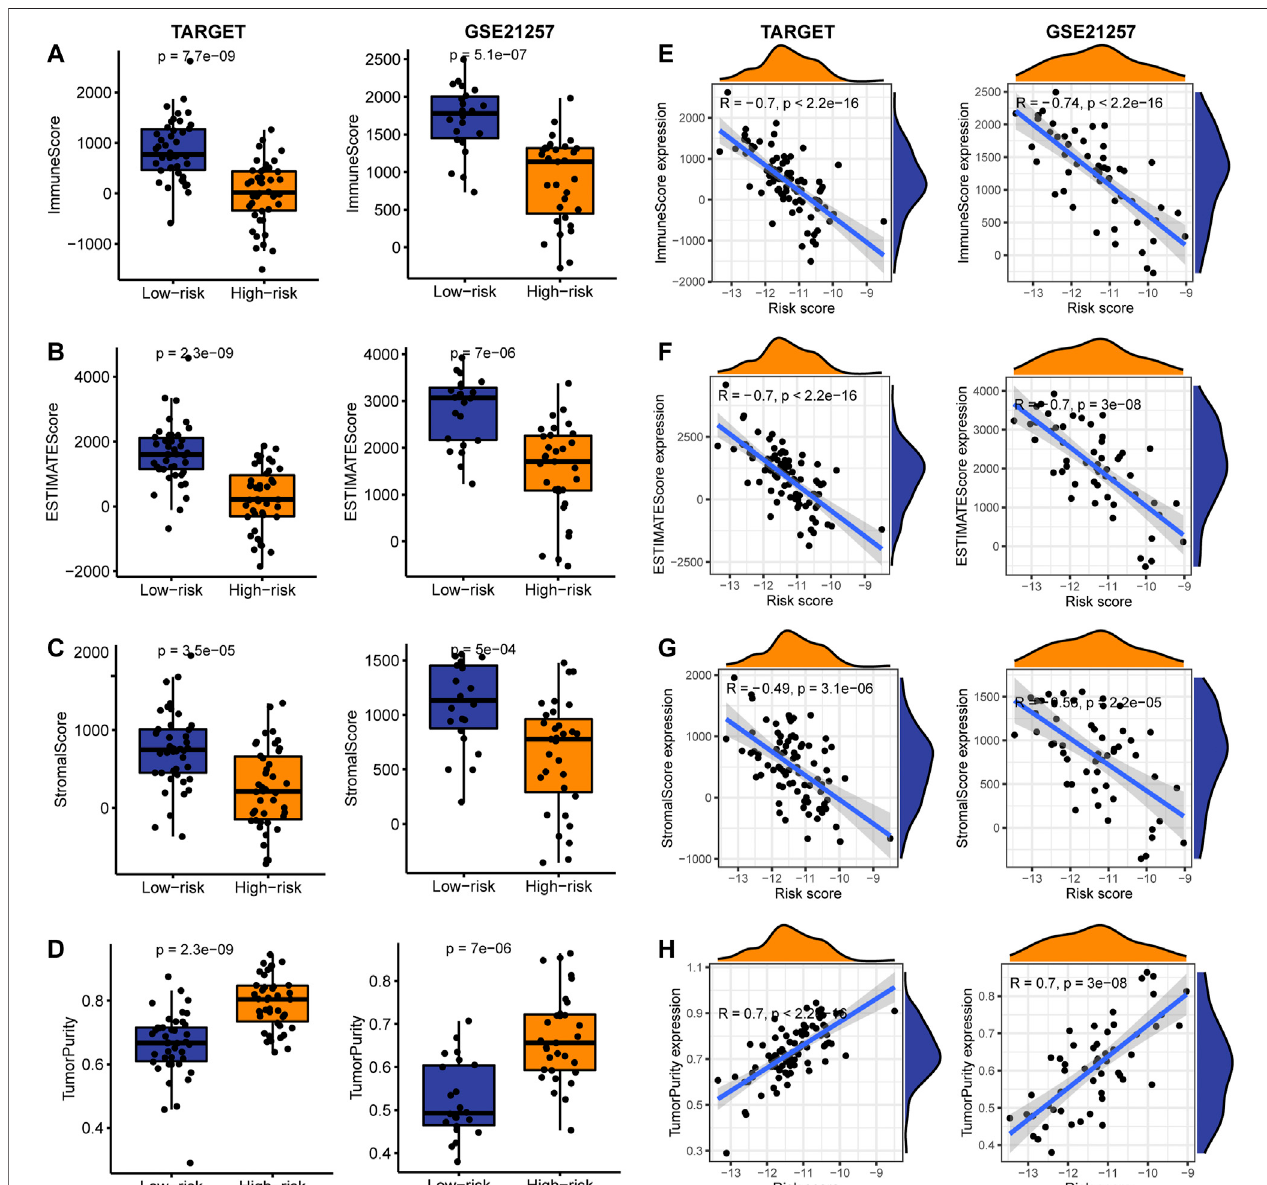
FIGURE 6 | Correlation between IRPS and TME in OS. (A – D) In the TARGET and GSE21257 cohorts, box plots of IRPS and (A) immune cell in fi ltration level, (B) ESTIMATE score, (C) stromal score, and (D) tumor purity. (E – H) Correlation between IRPS and (E) immunecell in fi ltration level, (F) ESTIMATE score, (G) stromal score, and (H) tumor